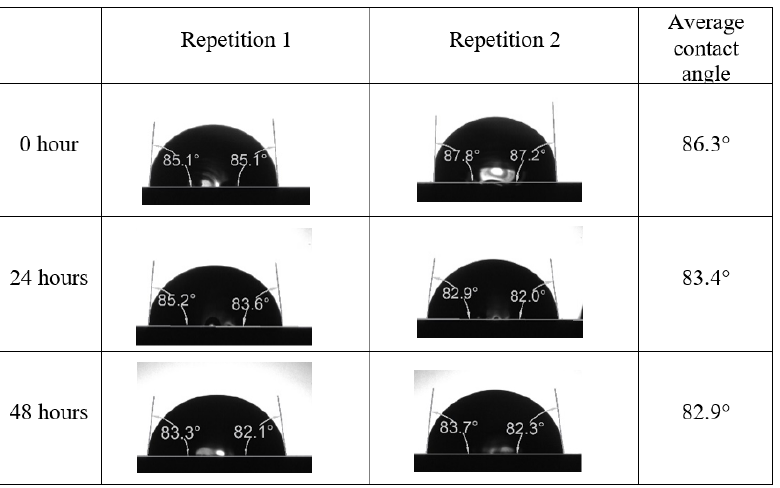
Figure A21. Dynamic Contact Angle Measurement Results for 50% Na 2 SO 4 + 50% KCl (3500 ppm).